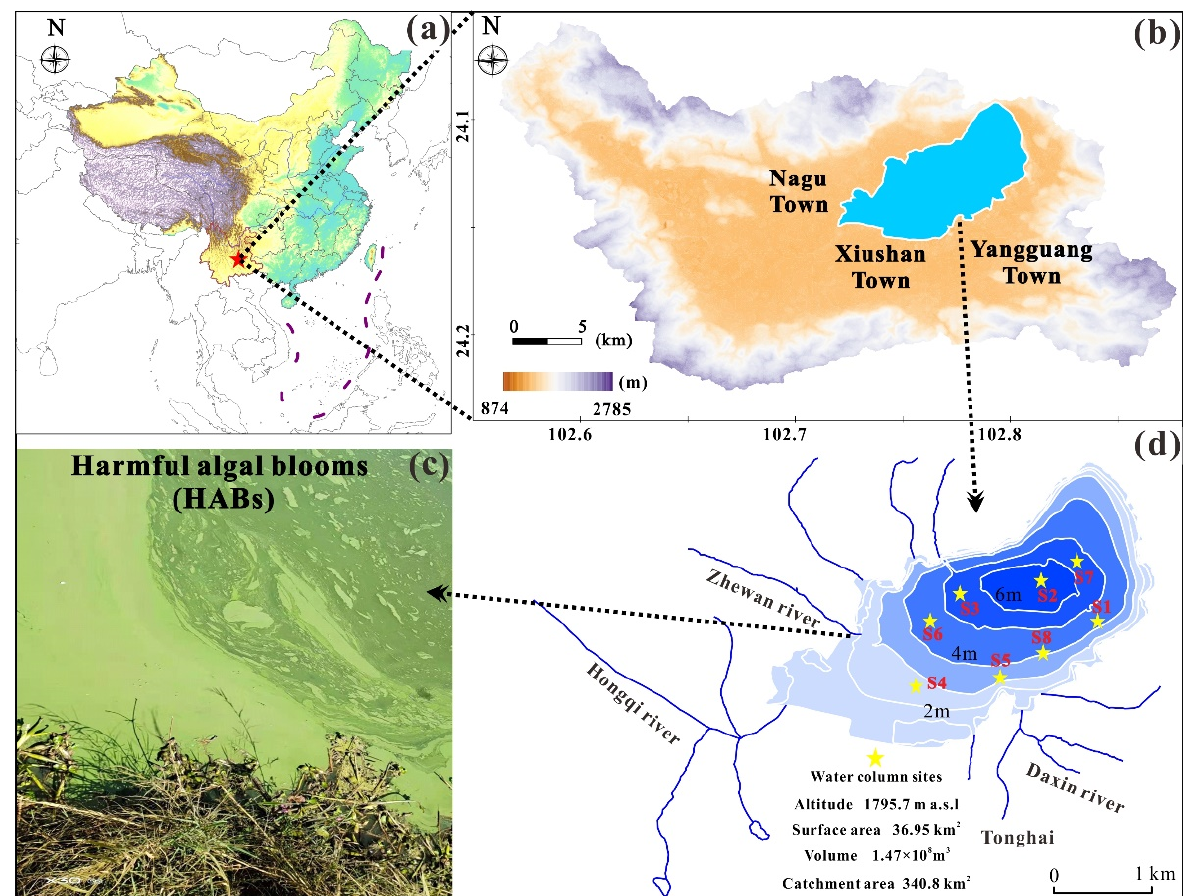
Figure 1. Sampling locations in Lake Qilu, southwestern China. ( a ) Location of lake Qilu; ( b ) Basin of Lake Qilu; ( c ) Main inflows in lake Qilu; and ( d ) the dense harmful algal blooms in lake Qilu. The lake area, located in southwestern China (Figure 1a), is characterized by a sub- tropical monsoon climate, with an average annual precipitation of 881.0 mm and an annual average temperature of 15.6 ◦ C. Lake QL is a closed shallow plateau lake with no obvious outlet and is discharged only through natural karst caves. Water input is derived mainly from rainfall and runoff. More than a dozen seasonal watercourses enter the lake, such as the Hongqi, Daxin, and Zhewan rivers. Lake QL is an important water resource for the city (Figure 1c). The basin of lake QL is the focus of social and economic development for the county and the basis for its survival and development. In Tonghai city, lake QL is colloquially referred to as the “Mother Lake” because it has various functions, including industrial and agricultural water usage, regulation and storage, flood control, shipping, tourism, aquaculture, etc.